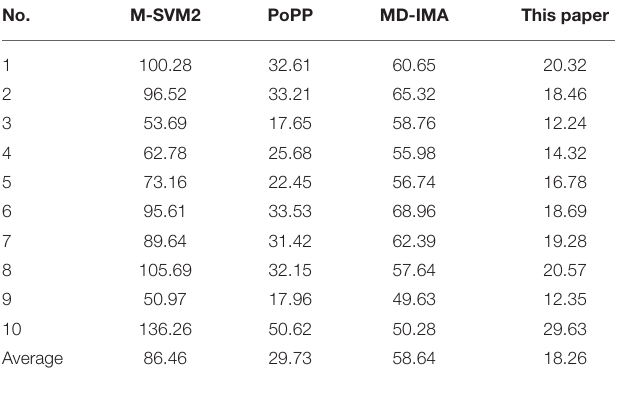
TABLE 2 | Recognition time of mental state recognition of undergraduates in medical college by different methods.